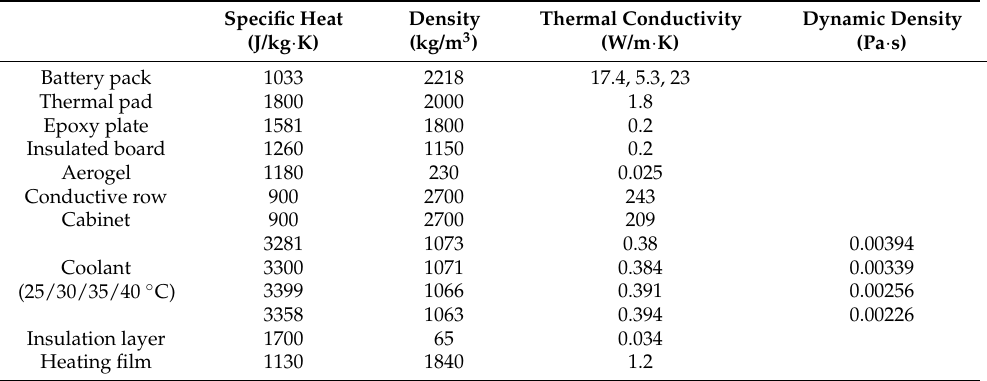
Table 3. CFD calculation